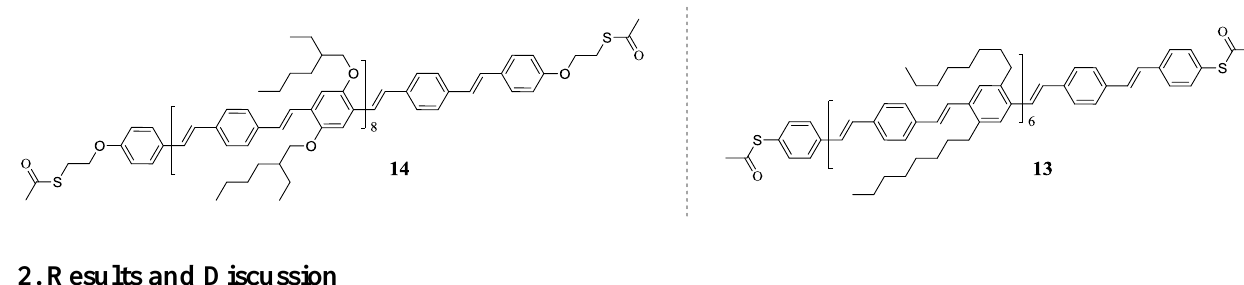
potential to create a fully conjugated wire if attached to separate electrodes (Figure 1). Figure 1. left : Chemical structure of previously reported oligomer 14 containing an aliphatic thioacetate functionality which allows for attachment between two separate gold electrodes, allowing it to function as a molecular wire [16]. As the thioacetate functionality is not in direct contact with the conjugate oligomer, the transport of electrons between the oligomer and the gold electrodes of electrons has to happen through tunneling. right : A newly synthesized oligomer 13 containing an aromatic thioacetate functionality which has the potential to create a fully conjugated organic system between two gold electrodes by creation of a Ar-S-Au bond.